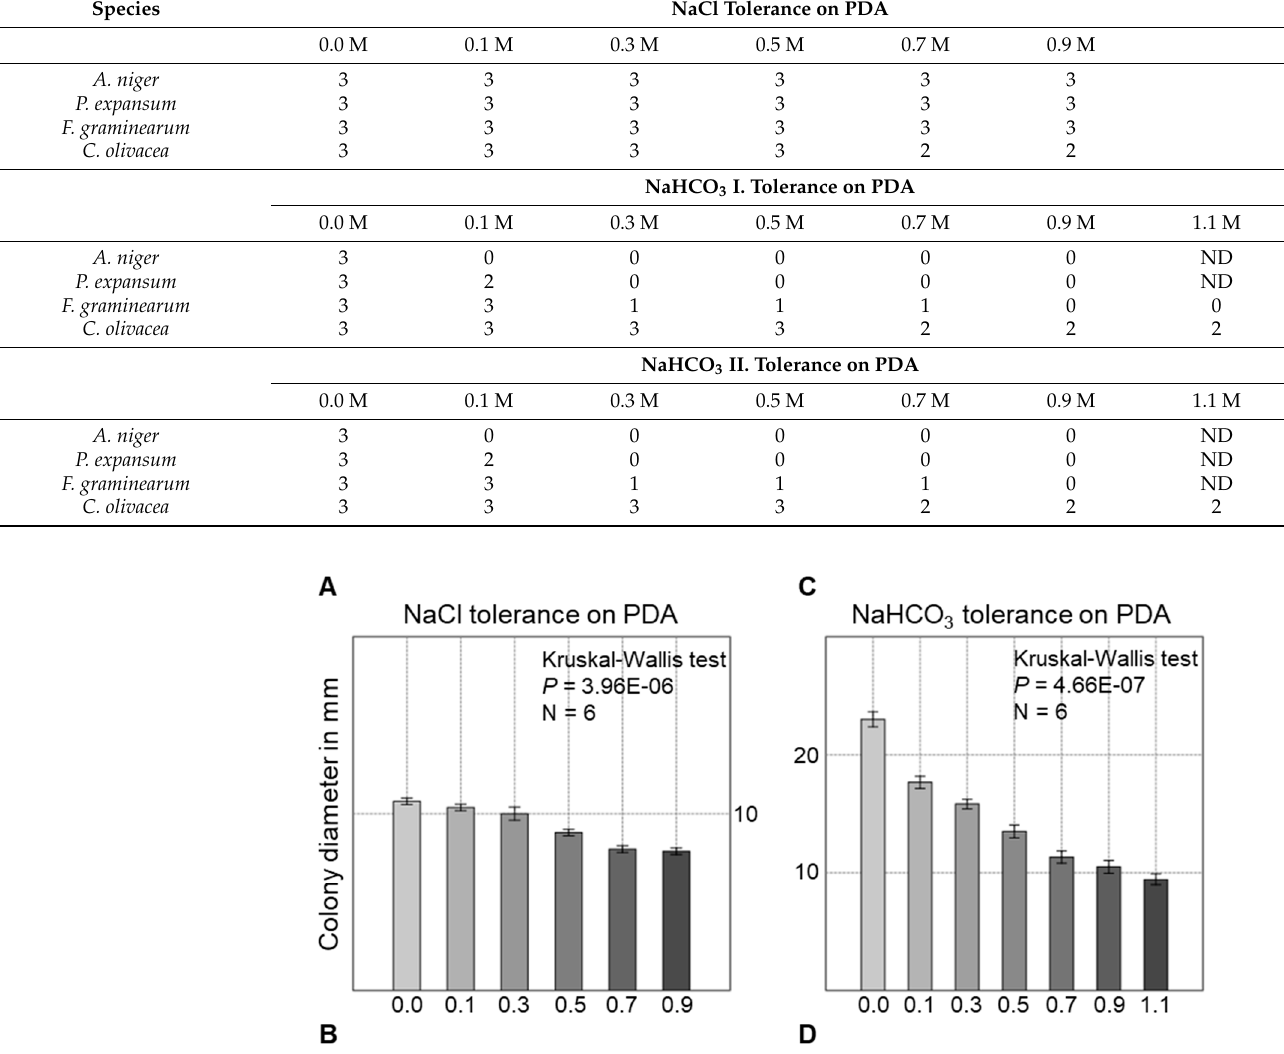
Table 2. Evaluation of the tolerance of the fungal strains to different concentrations of salts (see methods).